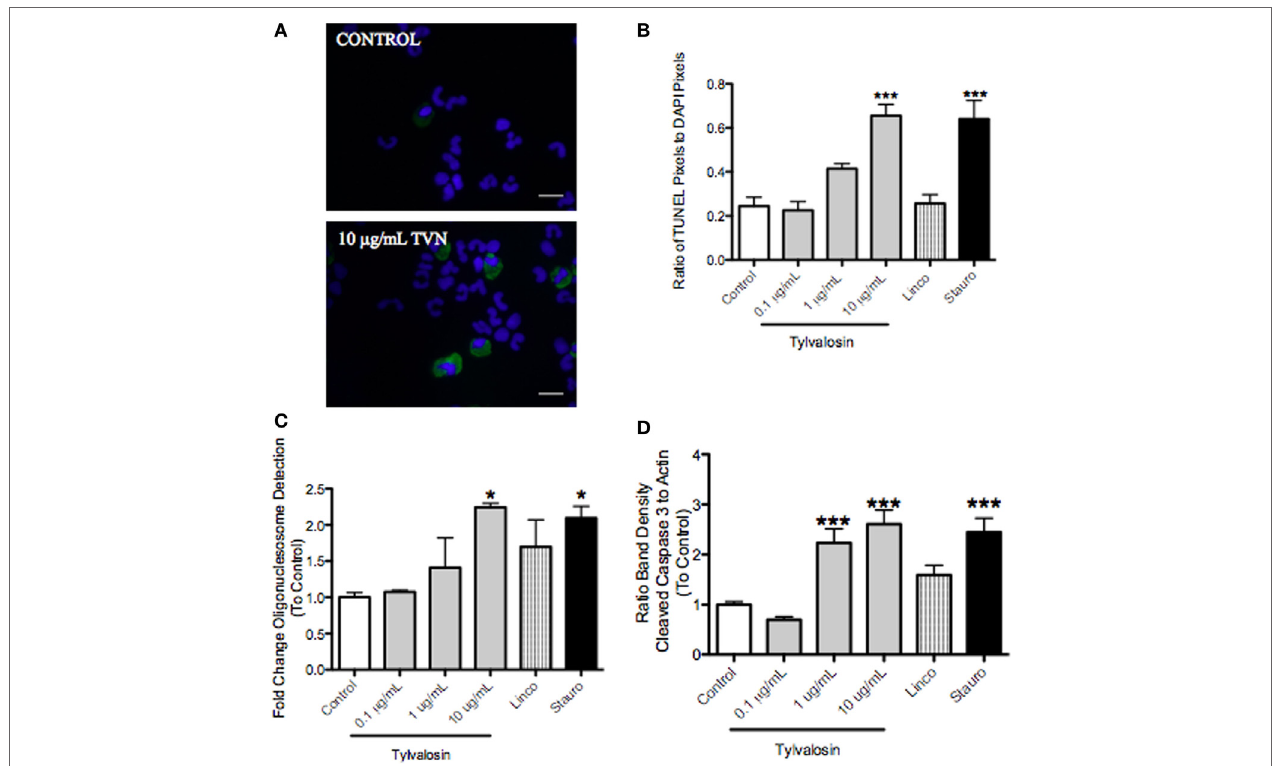
FigUre 1 | Tylvalosin induces apoptosis in porcine neutrophils. (a) Visual representation of fluorescent TUNEL staining of apoptotic neutrophils. Green depicts positive TUNEL staining in apoptotic cells; blue depicts DAPI-stained nuclei. Greater numbers of neutrophils positive for TUNEL (i.e. apoptosis) were found in the tylvalosin-treated group (1 h, 10 μ g/mL). Magnification 1,000x. (B) Quantification of TUNEL staining experiments after 1-h treatment. Values were calculated as a ratio of TUNEL pixels to DAPI pixels. Data are means ± ( n = 3–6/group) *** P < 0.001 versus control. (c) Cell death enzyme-linked immunosorbent assay (ELISA) showing levels of mono- and oglio-nucelosomes released during apoptotic death. Values were calculated as fold change of absorbance to control. Data are at 1 h posttreatment with control vehicle (10% FBS in HBSS), various concentrations of tylvalosin, lincomycin, and staurosporine (positive control). Data are means ± SEM ( n = 3–4/group) * P < 0.05 versus control. (D) Densitometry analysis of western blot data for fragmentation of pro-apoptotic caspase-3 relative to β -actin assayed in porcine neutrophils at 0.5 h posttreatment with control (10% FBS in HBSS), TVN (0.1, 1, or 10 μ g/mL), and positive control 1 μ M staurosporine or equimolar concentrations (11.3 μ M) of lincomycin. Values were calculated as the band density of cleaved caspase-3 (17 kDa) relative to β -actin (45 kDa), and expressed as a ratio to control. Data are expressed as group mean ± SEM ( n = 3–6/group). *** P < 0.001 versus